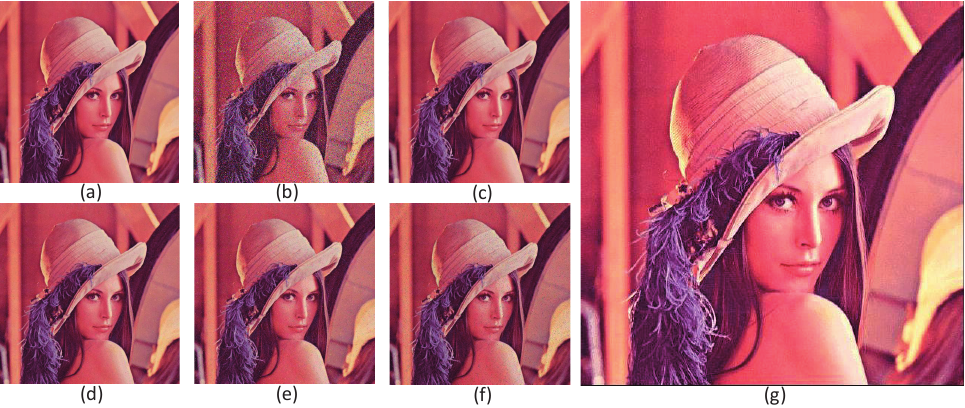
Figure 12. Filtered result. ( a ) Original image. ( b ) Lena added 5% salt and pepper noise. ( c ) Image denoised by SRMC operator. ( d ) Image denoised by median filter operator. ( e ) The image denoised by the 3 × 3 Gaussian filtering operator. ( f ) The image denoised by the 5 × 5 Gaussian filtering operator. ( g ) The image after the image sharpening